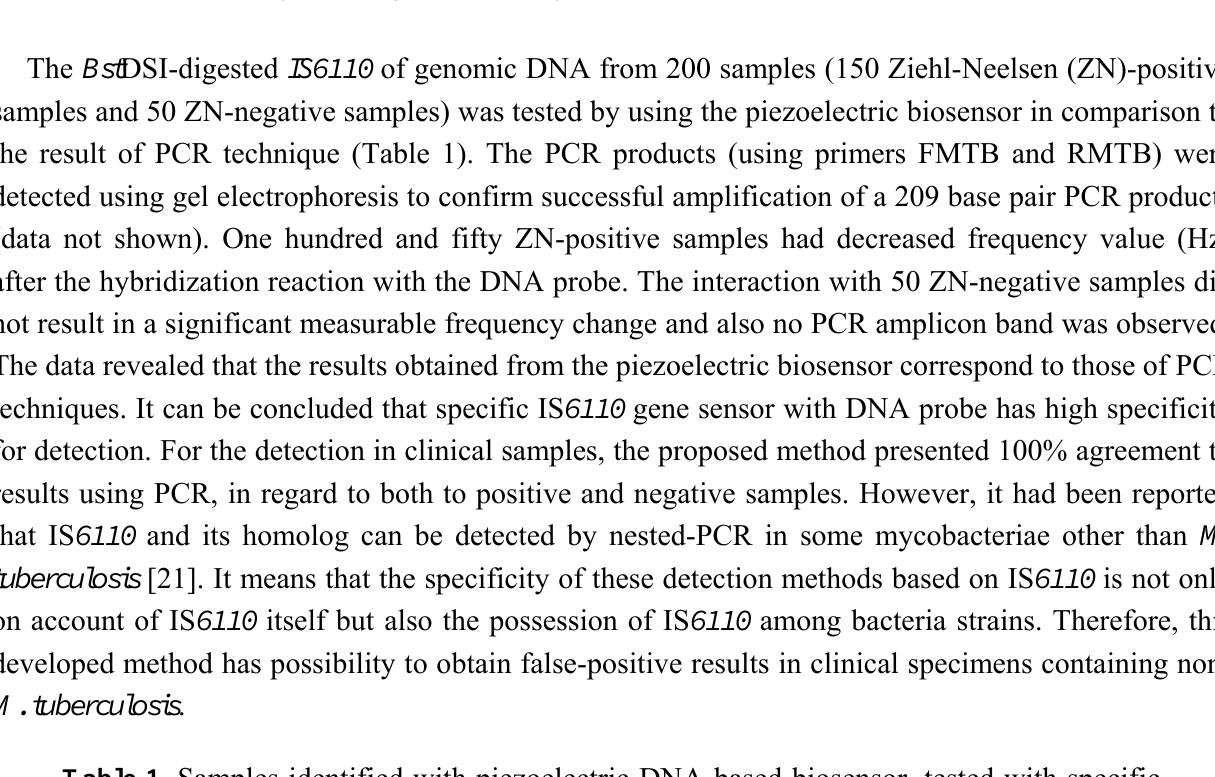
Table 1. Samples identified with piezoelectric DNA-based biosensor, tested with specific sensors carrying the IS 6110 probes for genotyping, compared with the PCR